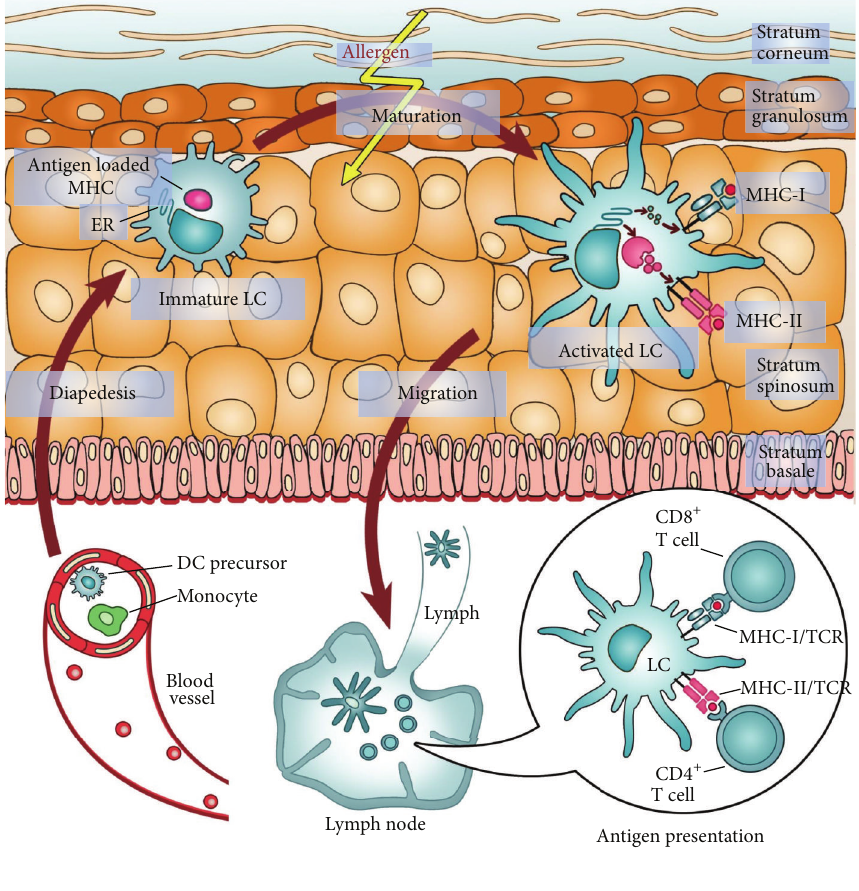
Figure 1: Skin exposure to allergens induces maturation of LCs and migration to regional lymph nodes. After disrupture of the epidermal barrier, haptens such chemicals gain access to the deeper compartment of the skin. Even in steady state, sentinels of the immune system, LCs, move their protrusions between the keratinocytes to the tip of the inner cornified cell layer to sample antigens. If an allergen is detected in the context of danger, the antigen-loaded LC leaves the epidermis and migrates to the lymph node where cytotoxic T cells and T helper cells are stimulated to proliferate and acquire a specific phenotype. After skin inflammation, LCs are recruited from blood monocytes and repopulate the epidermis. DC, dendritic cell; LC, Langerhans cell; MHC, major histocompatibility complex; TCR, T cell